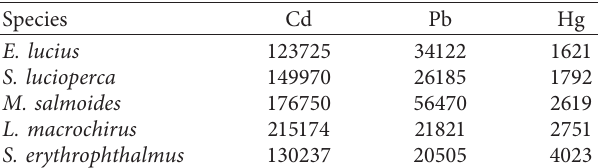
Table 9: Maximum safe consumption for Cd, Pb, and Hg in fish from the Mechraˆa-Hammadi Dam (g